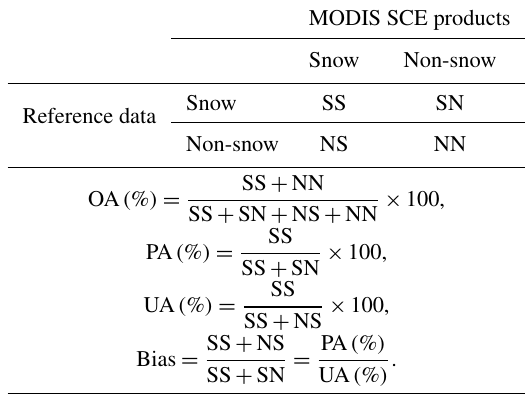
Table 4. Description of the confusion matrix used to validate or assess the associated SCE products ( SS , SN , NS , and NN are the numbers in each